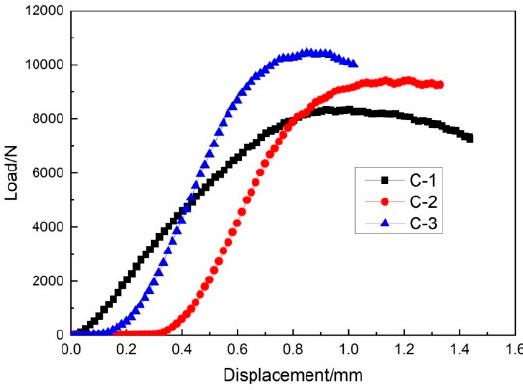
Figure 23. Warp compression load–displacement curve of sample C.